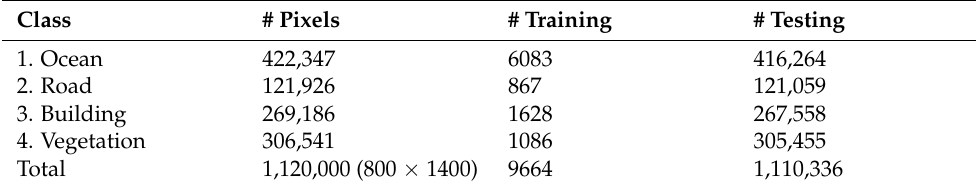
Table 1. The number of testing and training